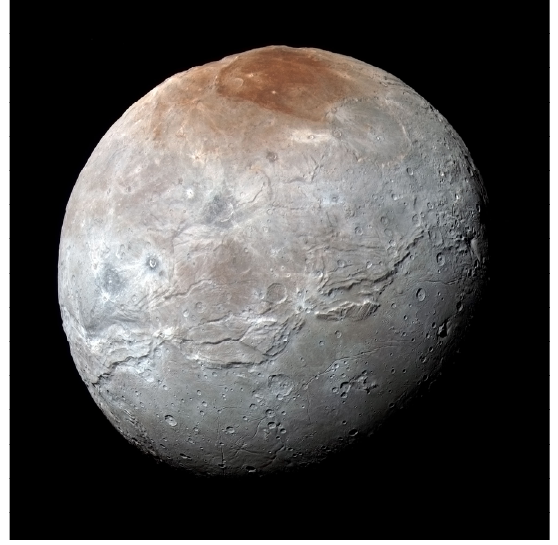
Figure 4. Encounter Hemisphere of Charon. This is a high- resolution enhanced color view of Charon taken near closest approach. The image combines blue, red and infrared images taken by the spacecraft's Ralph/Multispectral Visual Imaging Camera (MVIC); the colors are processed to best highlight the variation of surface properties across Charon. Charon's color palette is not as diverse as Pluto's; most striking is the reddish north (top) polar region, informally named Mordor Macula. Charon is 1,214 kilometers in diameter; image resolution is 1.4 km per